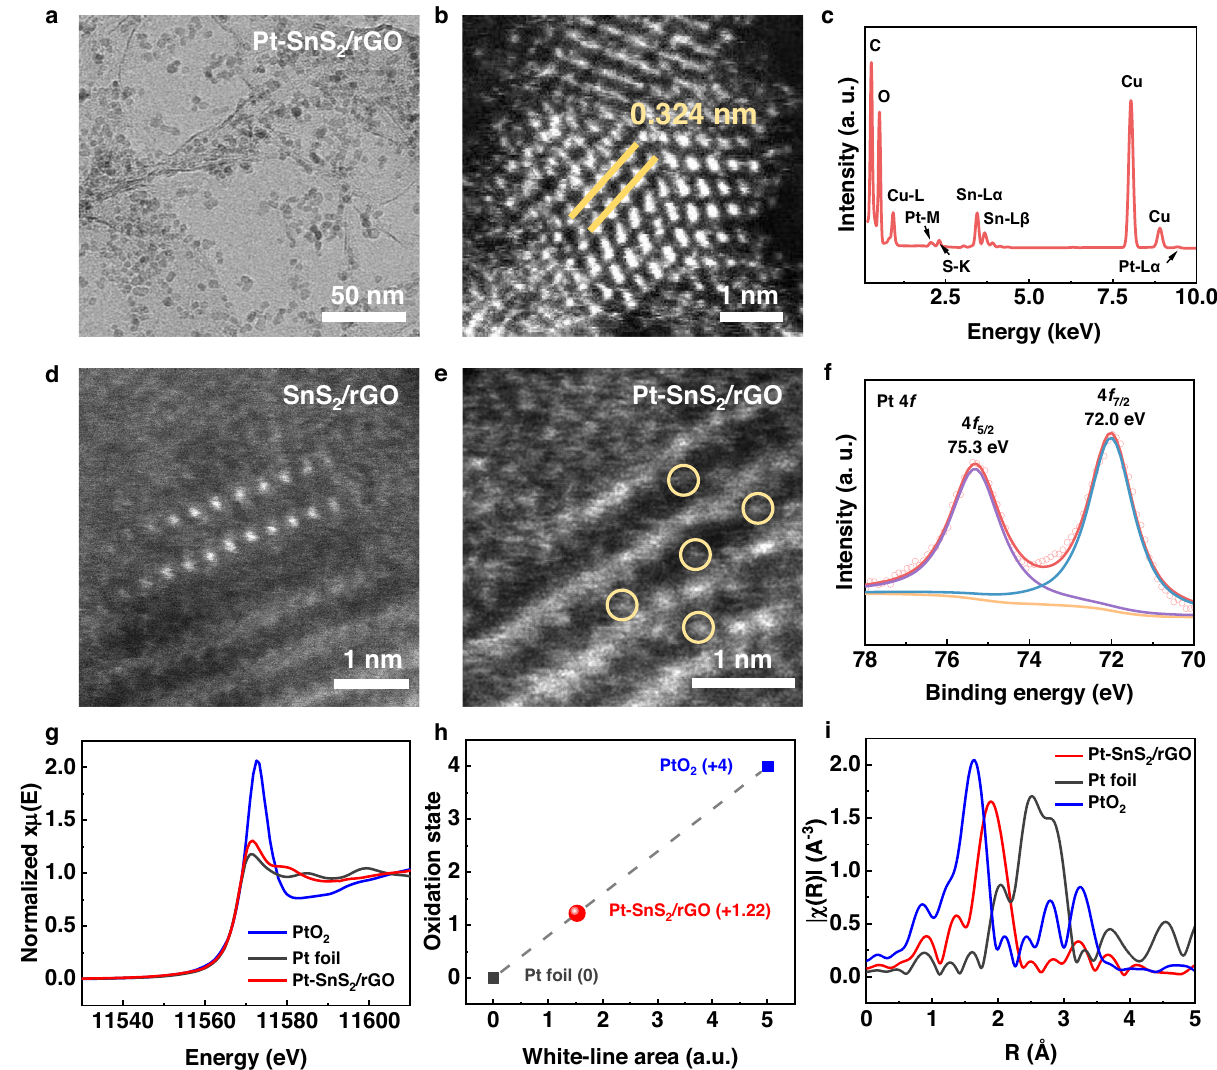
Fig. 2 | Structural characterization. a Bright- fi eld transmission electron micro- scopy (TEM) image of Pt-SnS 2 /rGO. b Scanning transmission electron microscopy high-angle annular dark- fi eld (STEM-HAADF) image of Pt-SnS 2 /rGO. c The energy- dispersive X-ray spectroscopy (EDS) spectrum of Pt-SnS 2 /rGO. d STEM-HAADF imageofverticalSnS 2 . e STEM-HAADFimageofPt-intercalatedverticalSnS 2 . f X-ray photoelectron spectroscopy (XPS) core-level spectrum of Pt 4 f for Pt-SnS 2 /rGO.